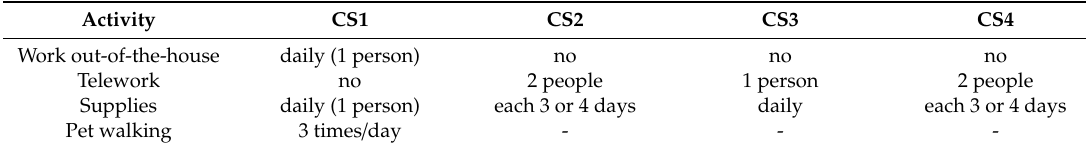
Table 3. Confinement home entry / exit